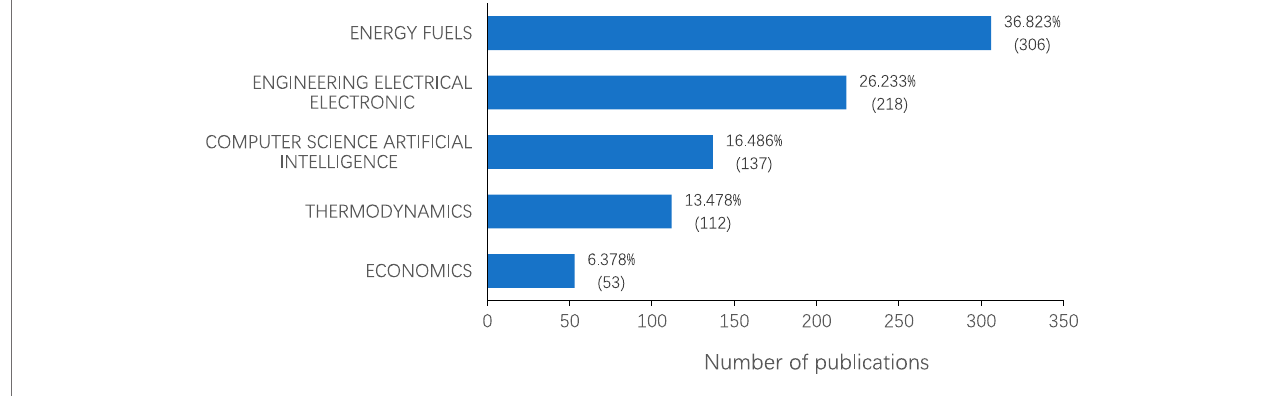
FIGURE 3 | Distribution of the main Subjects in electricity demand forecasting, 1999 – 2018.